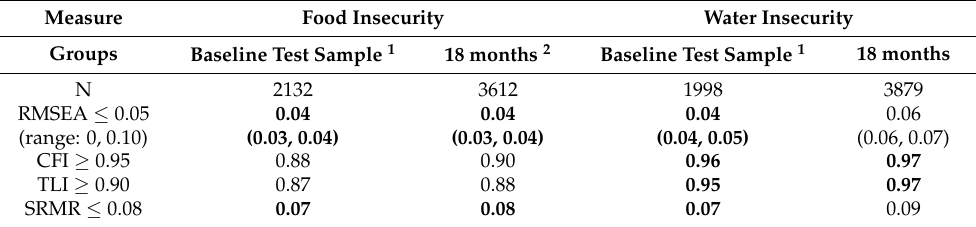
Table 5. Internal validity of multidimensional food insecurity and water insecurity